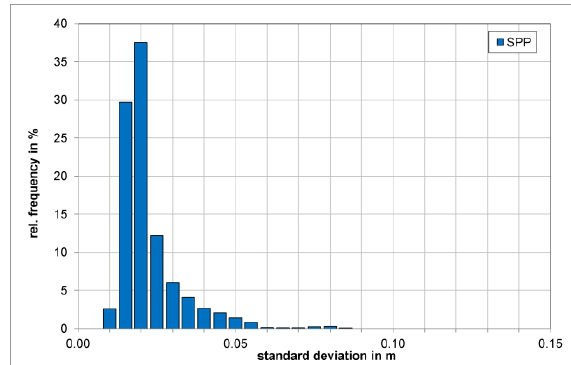
Figure 23. Histogram of short period precision (SPP) of LCF height calculated over intervals of length 500 m along the track of the cruise vessel.